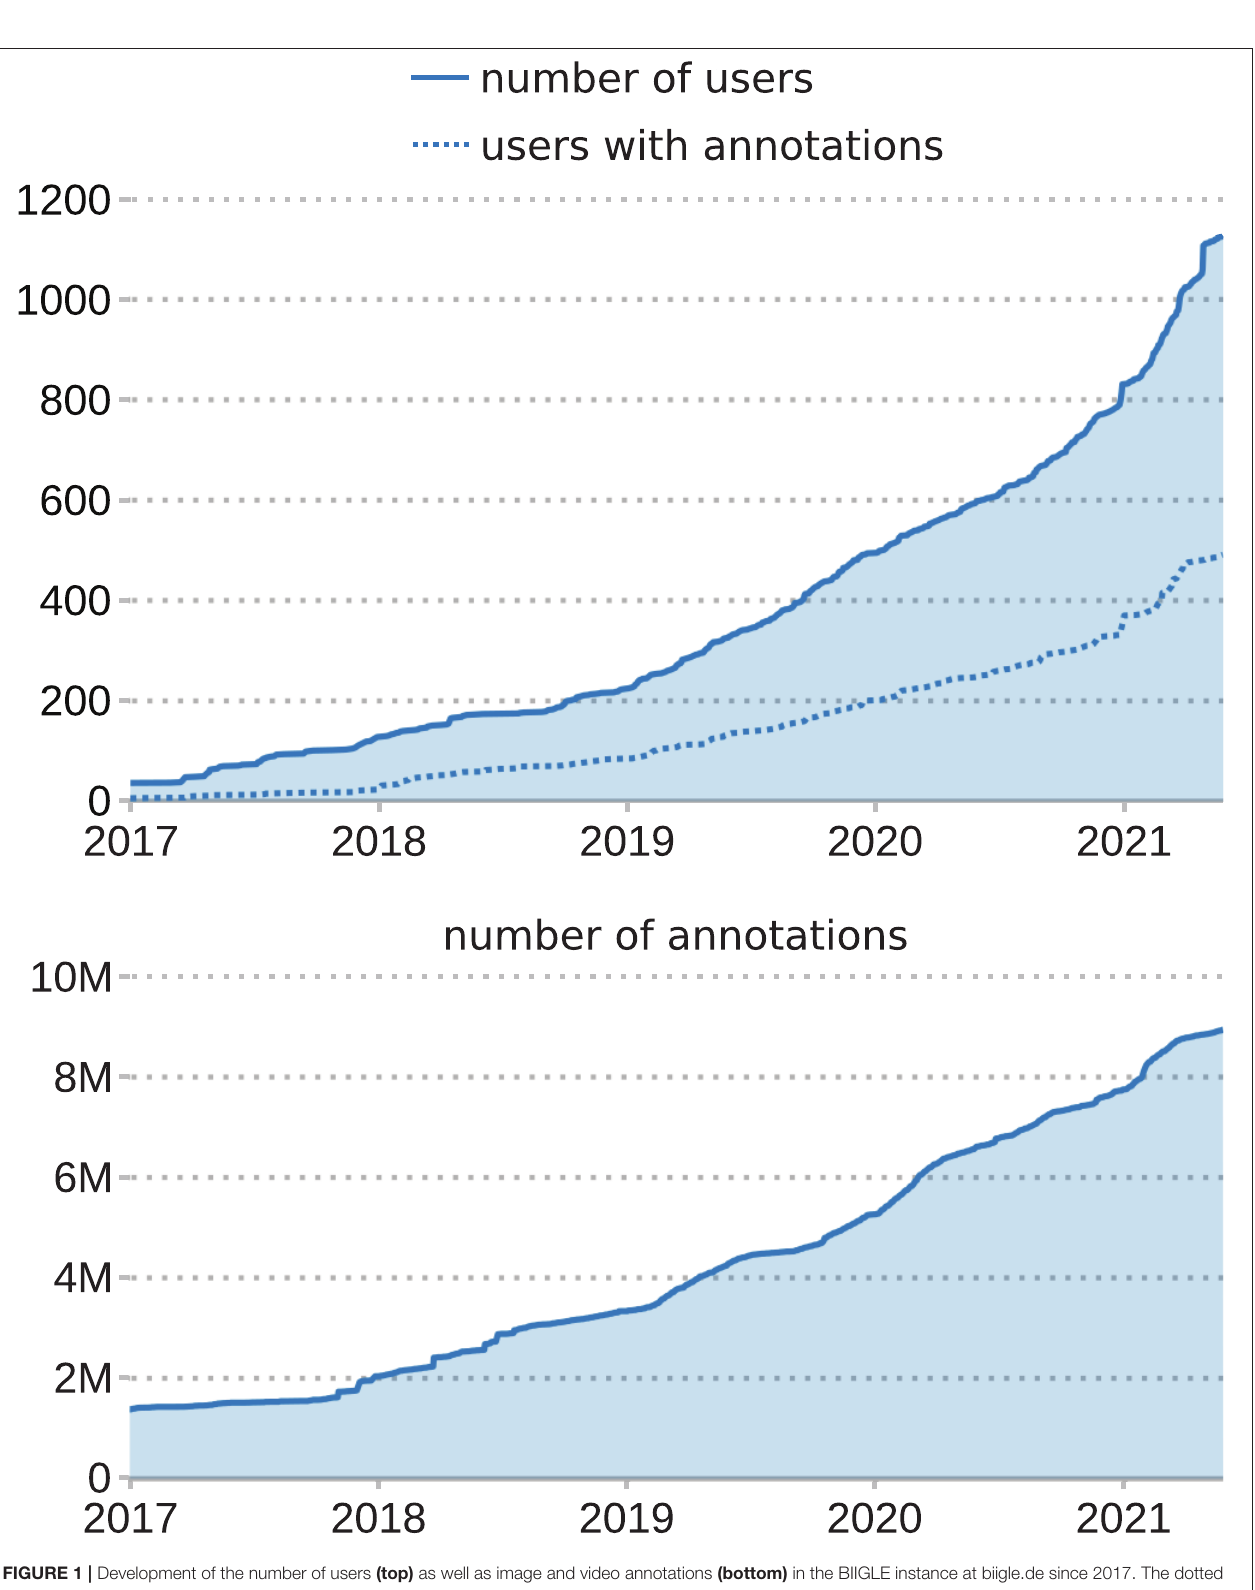
Frontiers in Marine Science |